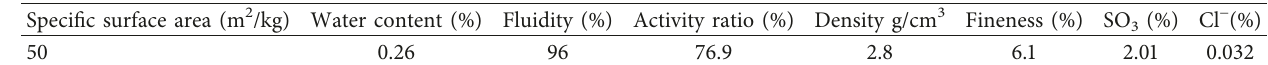
Table 2: Properties of mineral powders.